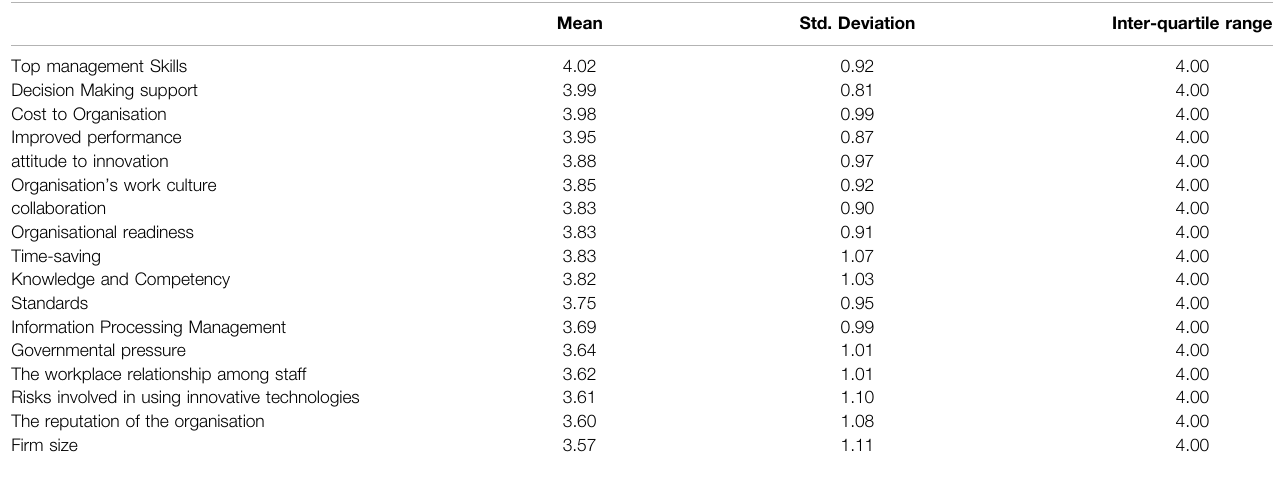
TABLE 4 | MIS analysis of organisational factors of AI adoption in the South African construction industry. Mean Std.